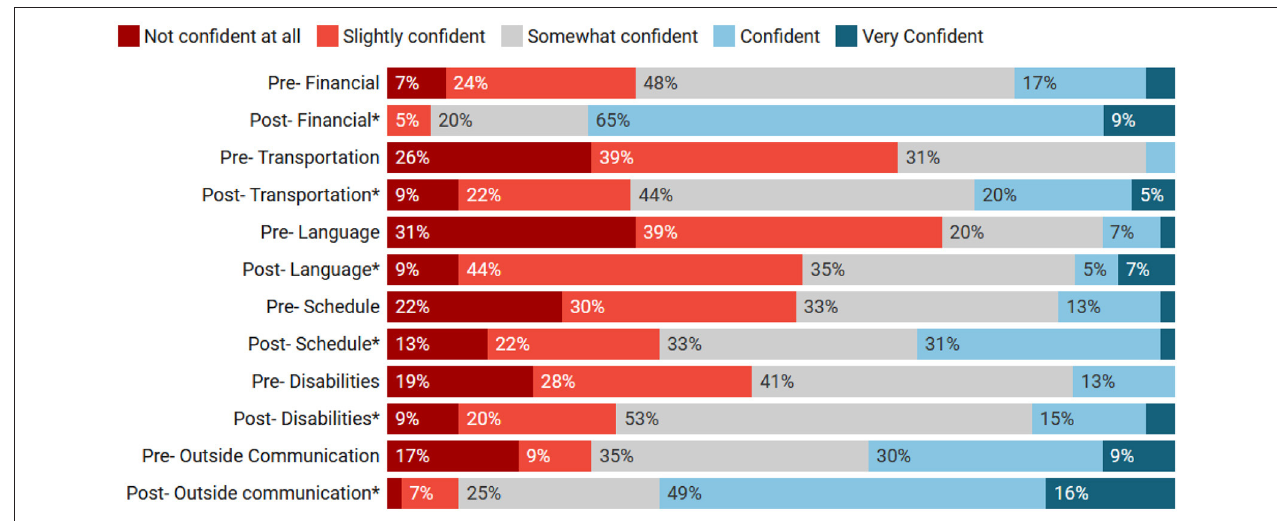
FIGURE 1 | Percentages of student confidence pre and post tufts at tech (TAT). *Pre and post-confidence levels are statistically significant.